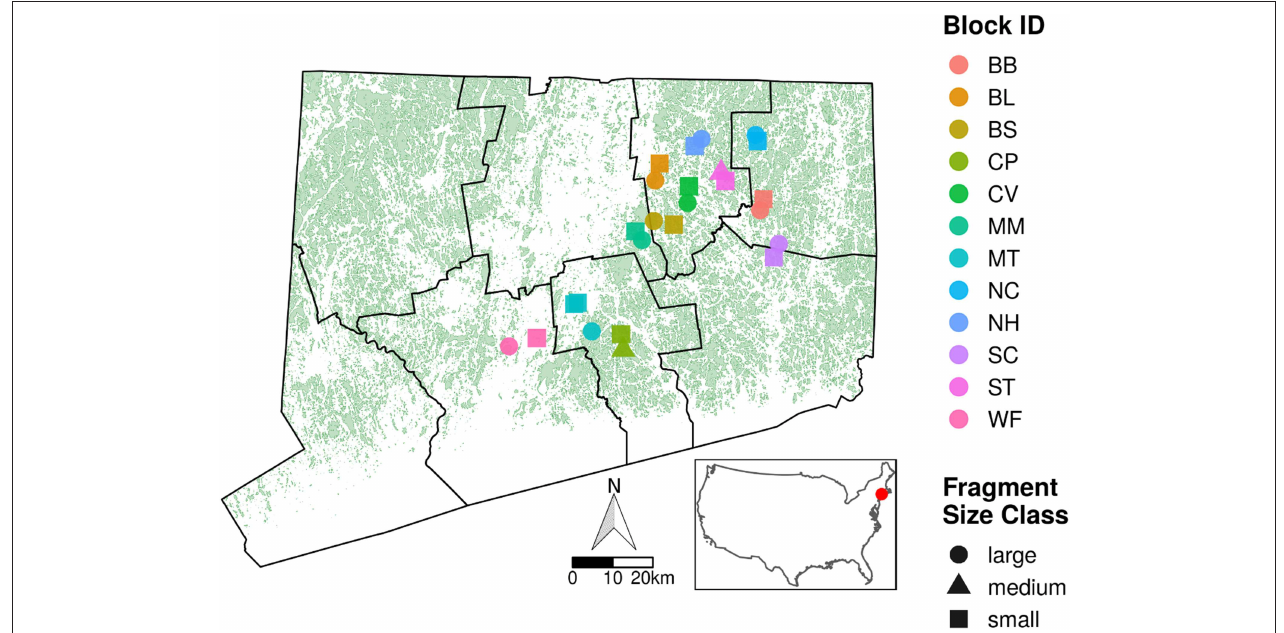
FIGURE 1 | Map of Connecticut with forest fragments in green, county boundaries in black, and inset showing the position of Connecticut within the United States. Superimposed on the map of Connecticut are our 25 study sites spanning a 3,500 km 2 area in east-central Connecticut. Experimental blocks are represented by different colors, and fragment area is indicated by shape. Large fragments are > 201 ha, medium sites are 51–200 ha, and small sites are < 50 ha. See Table 1 for further site and block information.